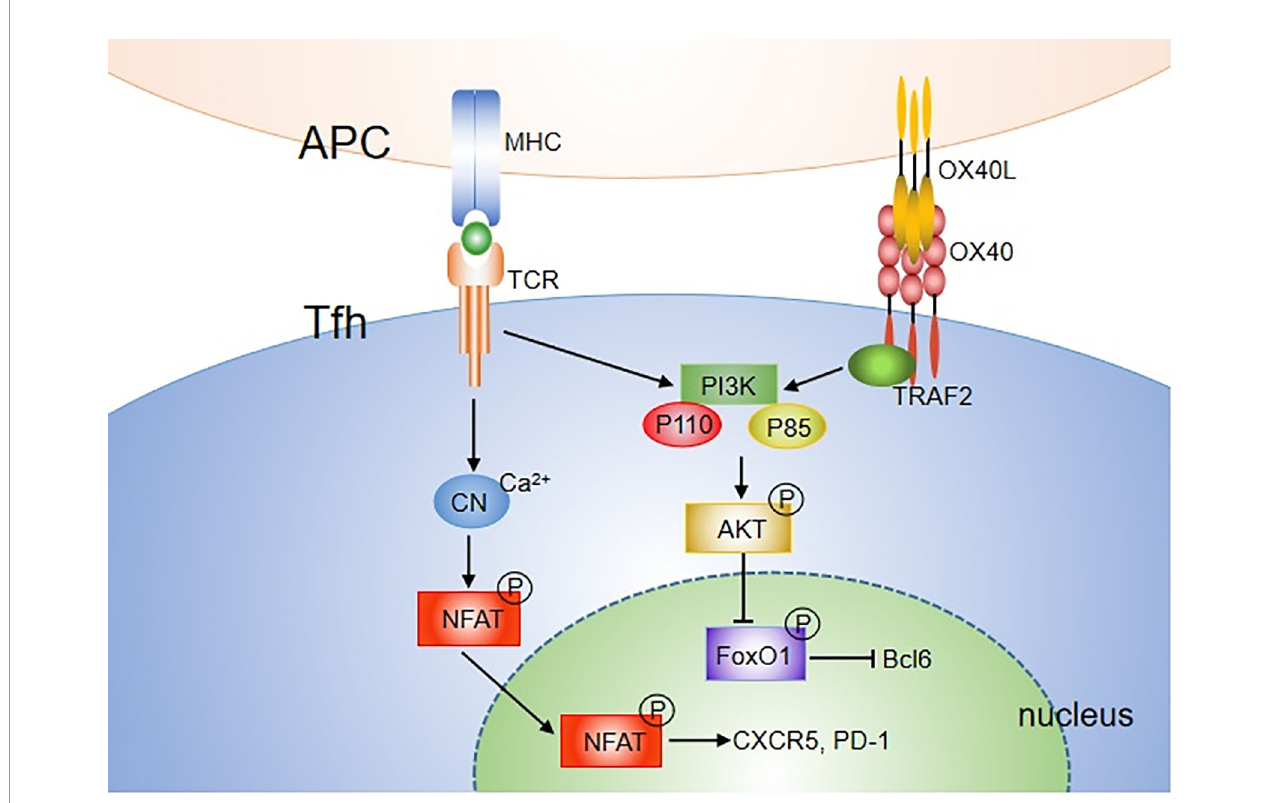
FIGURE 2 | OX40 signaling pathways mediating Tfh differentiation. Both TCR and OX40 can activate PI3K, including P110 and P85 subunit, further leading to phosphorylation of AKT. pAKT then phosphorylates the FOXO1 transcription factor, which can subsequently be exported out of the nucleus and degraded. FOXO1, which represses Bcl6, is recognized as an inhibitor of Tfh differentiation. In addition, OX40 synergizes with TCR to allow Ca 2+ in fl ux and nuclear accumulation of NFATc1 and NFATc2. Overall, OX40 may mediate Tfh cell activity by augmenting TCR signaling via the NFAT or PI3K-Akt